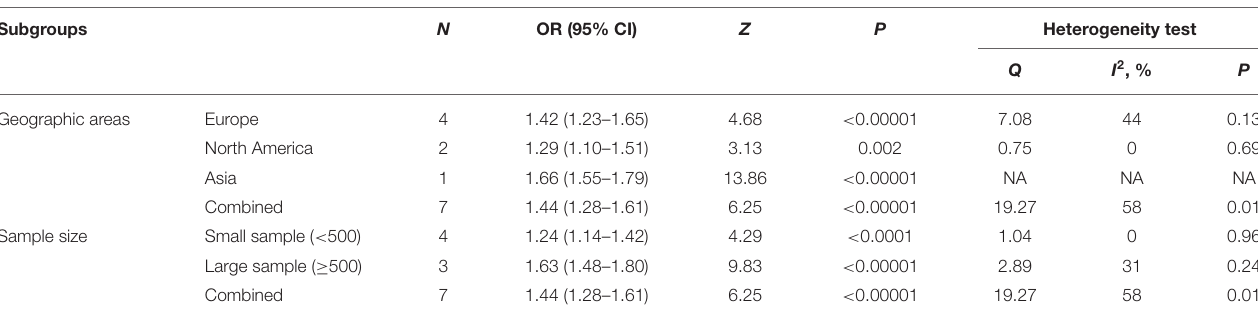
TABLE 4 | Subgroup analysis of the prevalence of hypertension in IIMs patients. Subgroups